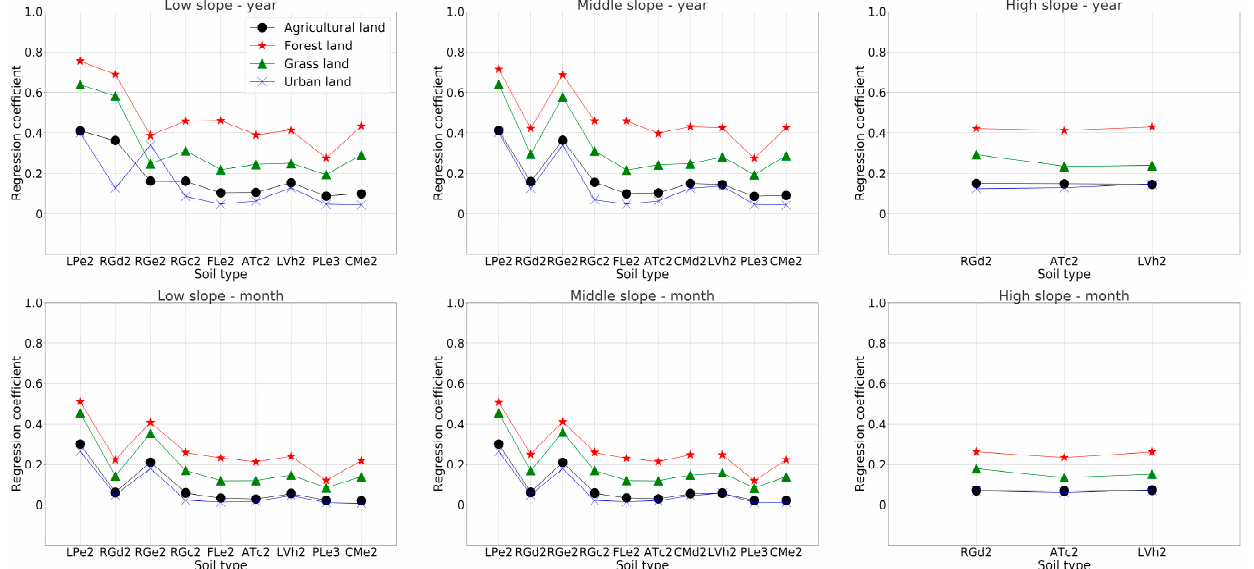
Figure 6. The RC between the precipitation and baseflow for different land uses, soil types, and slopes. The RC is the “a” of the equation “Baseflow = a × Precipitation + b” for each combination of land use, soil/hydrology group, and slope. The low slope, middle slope, and high slope represent the slope ranges 0–10, 10–25, and 25–40, respectively. “Year” and “month” mean the data of the samples were on a yearly and monthly scales, respectively. The soil type name of each soil type code is defined in Figure 3.